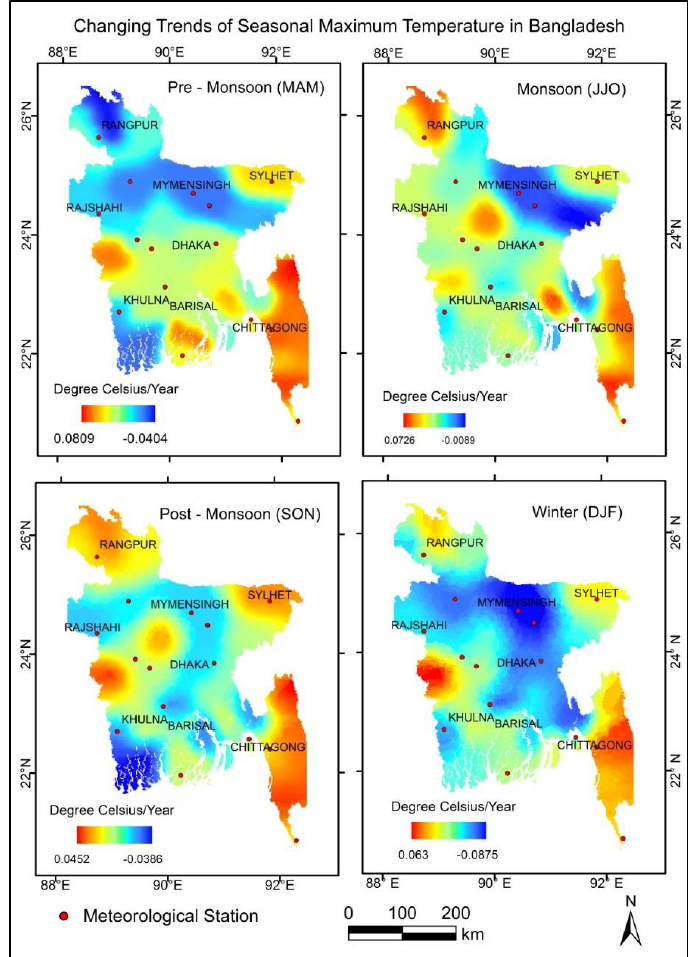
Figure 6. Geospatial distribution changing tends in seasonal average maximum temperature. Observations from Barisal meteorological station revealed both maximum and minimum